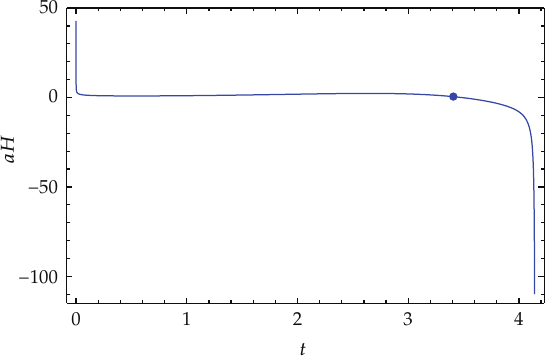
Figure 2: Comoving Hubble parameter aH/ (cid:2) a 0 H 0 (cid:3) versus t/t 0 . The dot indicates the value H (cid:9) 0 at t ∗ .